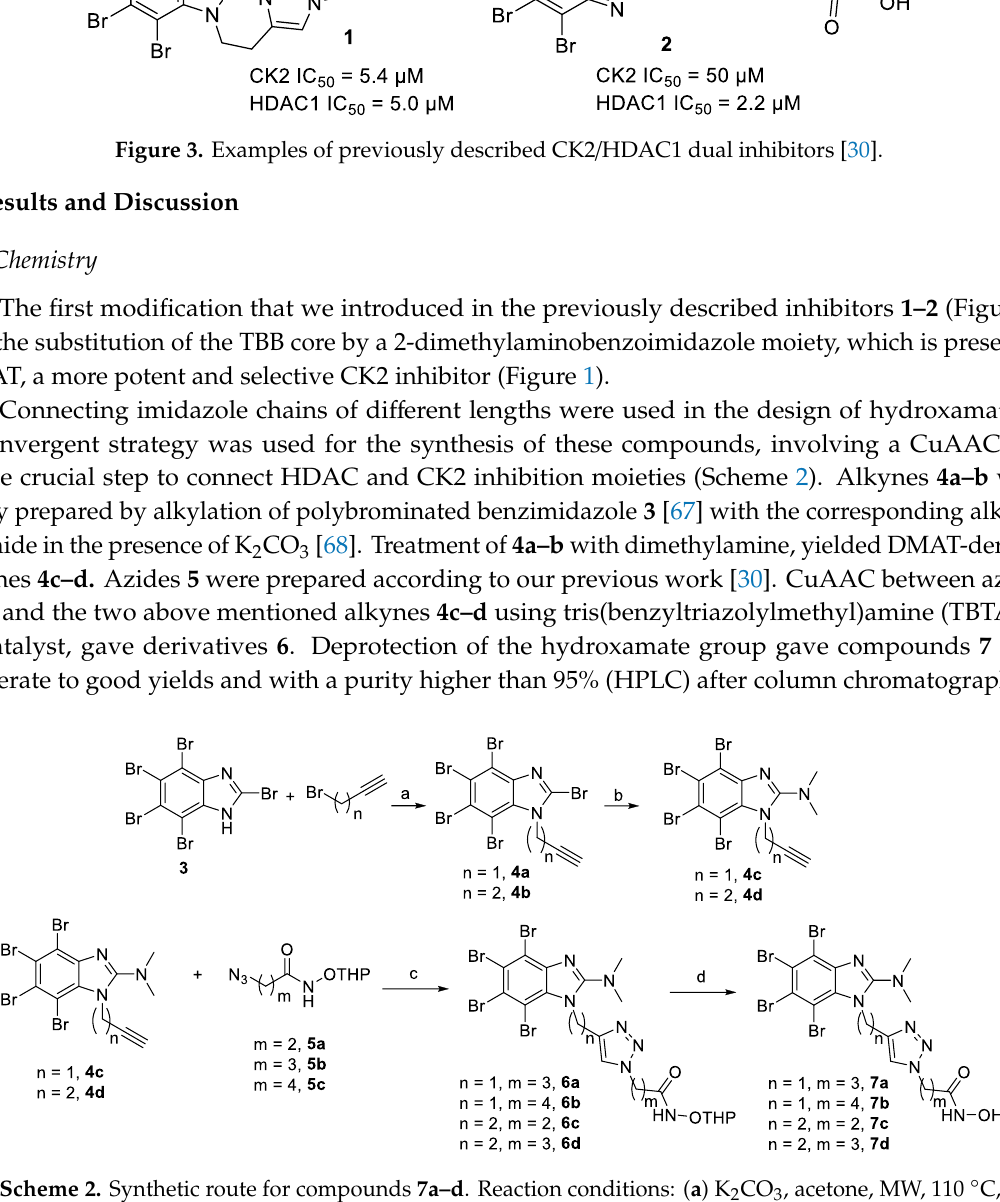
Scheme 2 a . Synthetic route for compounds 7a-d